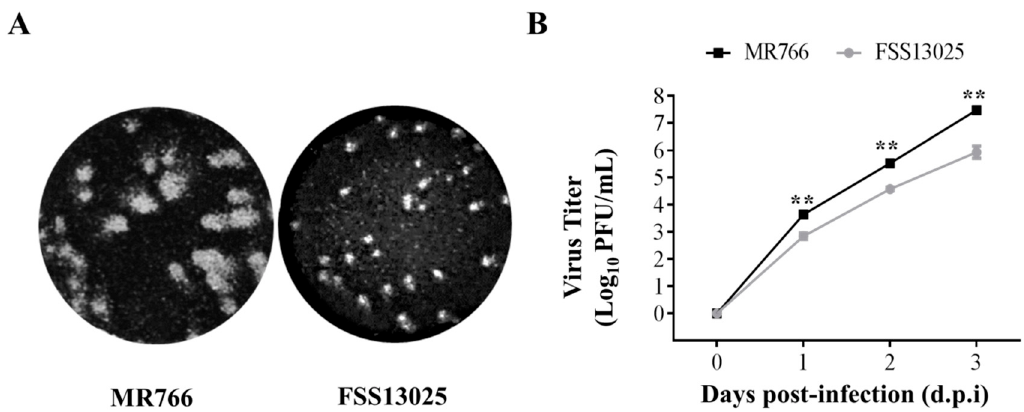
10 5 /well) Figure 4. Comparison of cDNA-derived MR766 and FSS13025 virus growth. Vero cells (2.5 × Figure 4. Comparison of cDNA-derived MR766 and FSS13025 virus growth . Vero cells (2.5 × in 12-well plates were co-transfected with 1 µ g pTight-ZIKV/MR766 or pTight-ZIKV/FSS13025 DNA 10 5 /well) in 12-well plates were co-transfected with 1 μ g pTight-ZIKV/MR766 or and 1 µ g pTet-On vector, followed by the addition of 1 µ g/mL Doxycycline to cell culture media. pTight-ZIKV/FSS13025 DNA and 1 μ g pTet-On vector, followed by the addition of 1 μ g/mL Infectious virus titers in the supernatants collected at day 3 (MR766) or day 6 (FSS13025) were quantified Doxycycline to cell culture media. Infectious virus titers in the supernatants collected at day 3 by a plaque assay. ( A ) Plaque formation by cDNA-derived ZIKV/MR766 and ZIKV/FSS13025 viruses. (MR766) or day 6 (FSS13025) were quantified by a plaque assay. ( A ) Plaque formation by Vero cells in 12-well cell culture plate were infected with 30 PFU of either MR766 or FSS13025. Plaques cDNA-derived ZIKV/MR766 and ZIKV/FSS13025 viruses. Vero cells in 12-well cell culture plate were were stained and visualized after 4 days (for MR766) or 6 days (for FSS13025) p.i. ( B ) Growth curves infected with 30 PFU of either MR766 or FSS13025. Plaques were stained and visualized after 4 days of cDNA-derived MR766 and FSS13025 viruses. To compare the growth ability between MR766 and (for MR766) or 6 days (for FSS13025) p.i. ( B ) Growth curves of cDNA-derived MR766 and FSS13025 FSS13025, 4 10 5 Vero cells seeded in 6-well plates were infected with MR766 or FSS13025 virus at × viruses. To compare the growth ability between MR766 and FSS13025, 4 × 10 5 Vero cells seeded in 0.01 MOI at 37 ◦ C for 1 h. Upon washing with phosphate-buffered saline (PBS) three times, infected 6-well plates were infected with MR766 or FSS13025 virus at 0.01 MOI at 37 °C for 1 h. Upon washing Vero cells were incubated with 2 mL DMEM containing 10% FBS. At day 1, 2, and 3 post-infection, with phosphate-buffered saline (PBS) three times, infected Vero cells were incubated with 2 mL virus in the supernatant was collected and stored at 80 ◦ C. Virus yields at different time points were − DMEM containing 10% FBS. At day 1, 2, and 3 post-infection, virus in the supernatant was collected determined by a plaque assay. Data points represent the mean titer of triplicates. Statistical significance and stored at − 80 °C. Virus yields at different time points were determined by a plaque assay. Data was analyzed by Student’s t -test: ** p < points represent the mean titer of triplicates. Statistical significance was analyzed by Student’s t -test: ** p < 0.01.